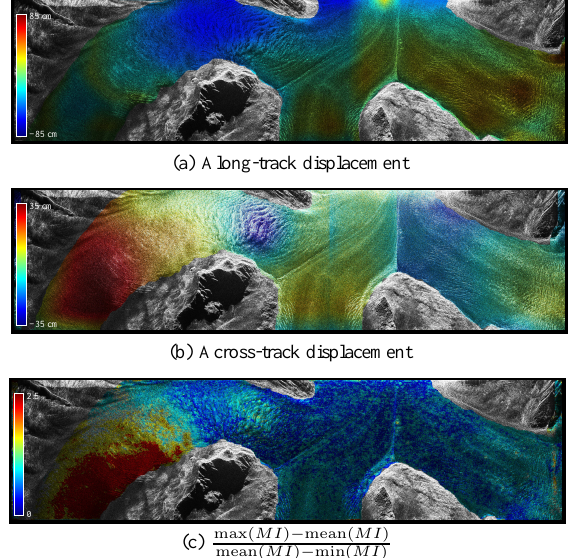
Figure 2: Retrieval of the along-track (a) and across-track (b) dis- placements, after a 1 day time interval, using the proposed polari- metric tracking. (c) The robustness map. The horizontal direction corresponds to the along-track whereas the vertical direction cor- responds to the across-track